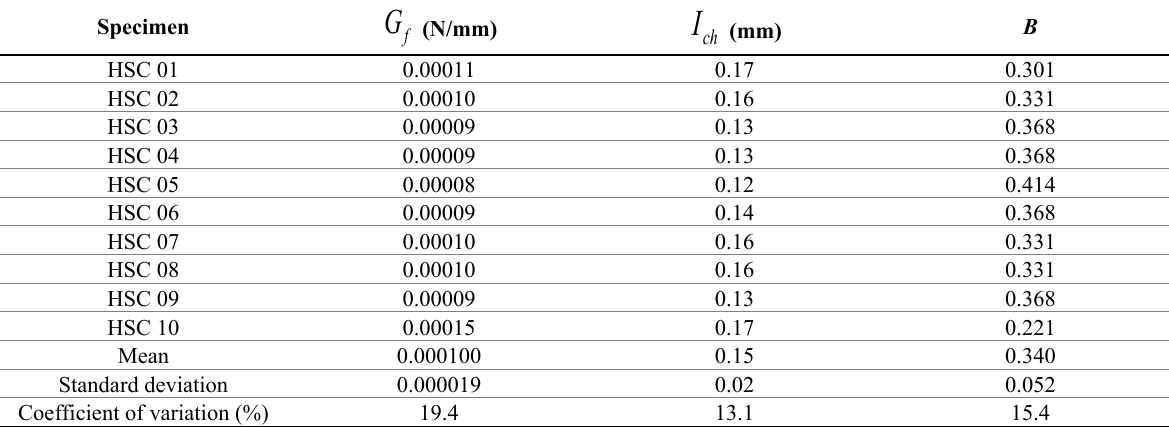
Table 4. High strength concrete characteristic length and brittleness Specimen